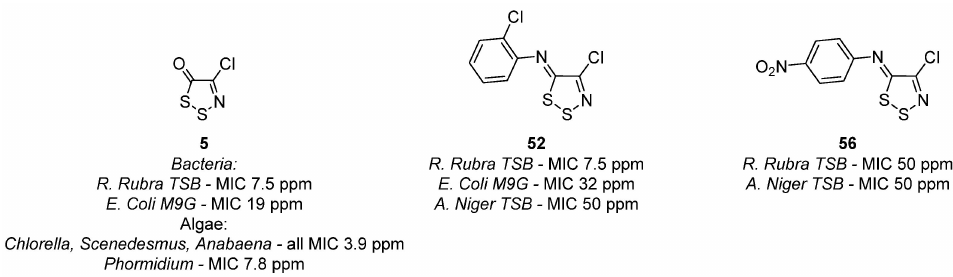
Figure 9. Rohm & Haas Co. filed a patent for industrial applications around three 1,2,3-dithiazoles for antibacterial and antialgae